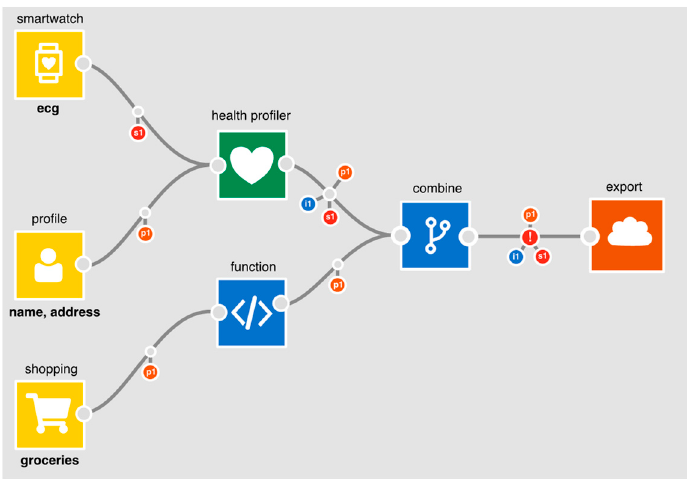
Figure 5. Health Insurance quote app.